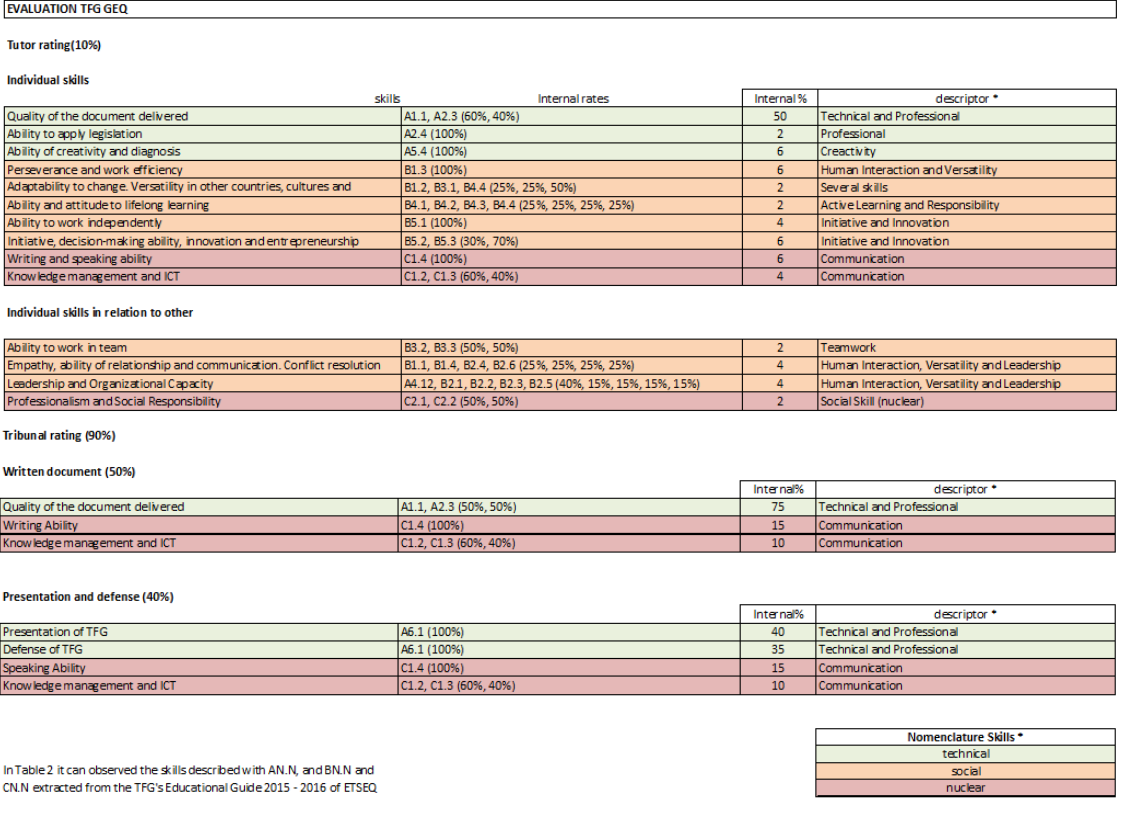
Table 1. Competences evaluated in the TFG of GEQ of ETSEQ and its percent